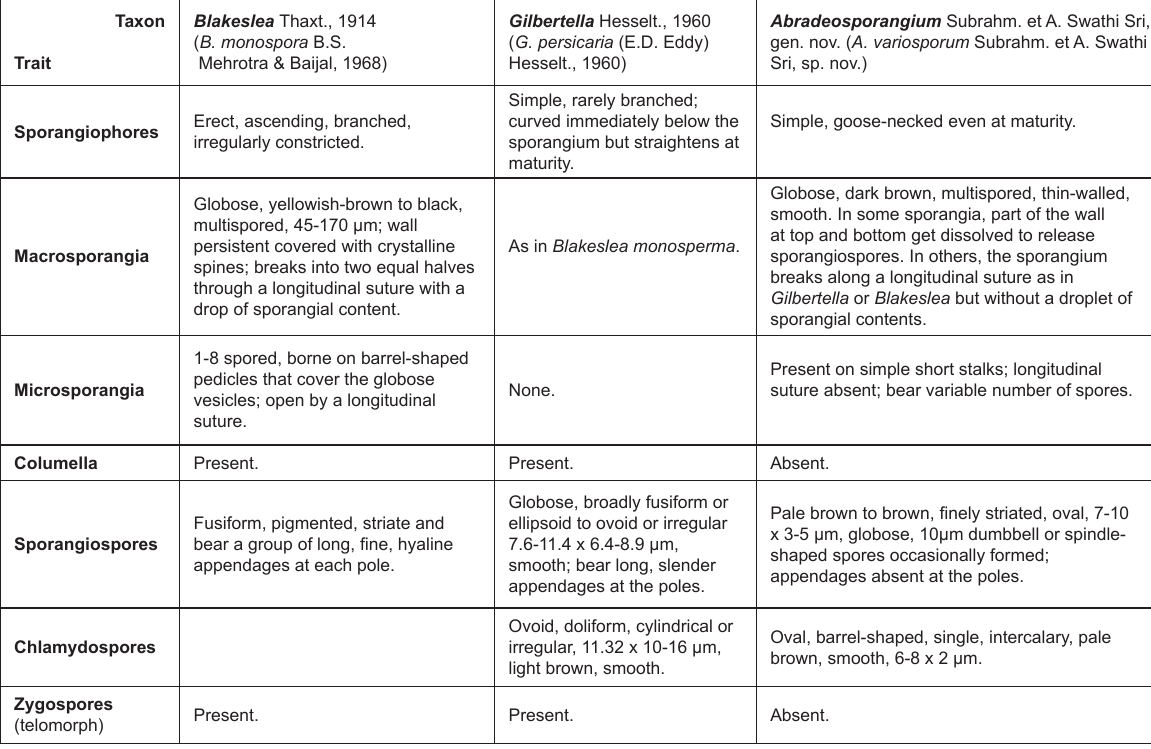
Table 1. Comparison of diagnostic characters of Blakeslea, Gilbertella and Abradeosporangium gen.